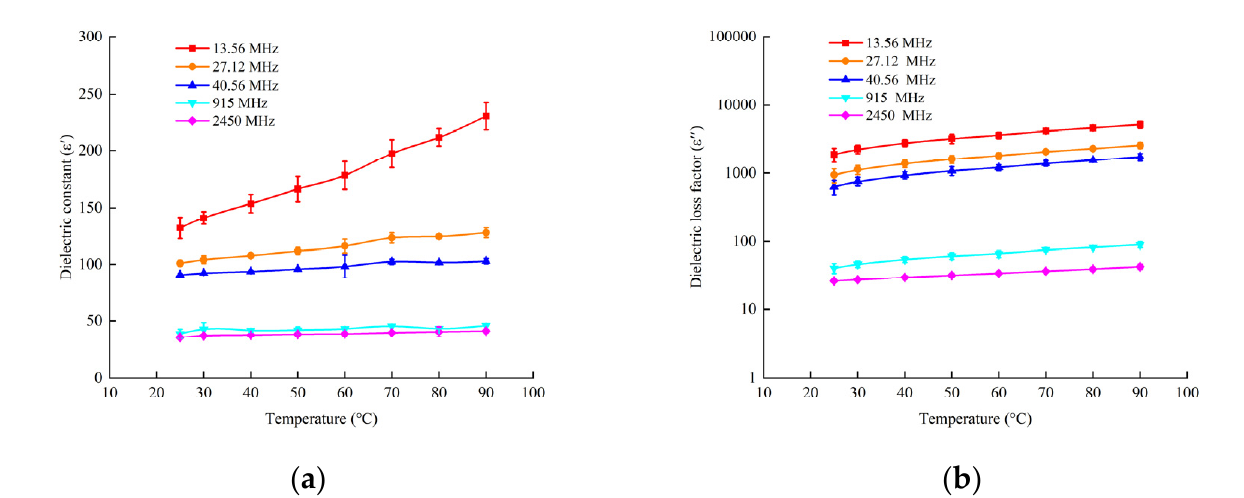
Figure 5. Temperature-dependent DPs of samples at five selected frequencies: ( a ) dielectric constant ( ε′ ) as dependent variable, ( b ) dielectric loss factor as dependent variable. RF band included 13.56, 27.12 and 40.68 MHz; microwave frequency included 915 and 2450 MHz. Two predictive models of ε′ and ε ″ were created as a function of temperature (T) and frequency ( f ) by nonlinear regression analysis in beef sausage sample in Equations (2) and (3). Both temperature (T) and frequency ( f ) had significant effects on the ( ε′ ) and ( ε ″ ), and the R 2 values were 0.941 and 0.951, respectively ( p < 0.001). ε (cid:48) = 183.937 − 3.129 f + 0.160 T + 0.004 f 2 + 0.006 T 2 − 0.01 fT − 1.316 × 10 − 6 f 3 − 1.323 × ε (cid:48)(cid:48) = 2925.437 − 90.397 f + 28.767 T + 0.131 f 2 + 0.024 T 2 − 0.043 fT − 3.84 × 10 − 5 f 3 + 3.797 ×